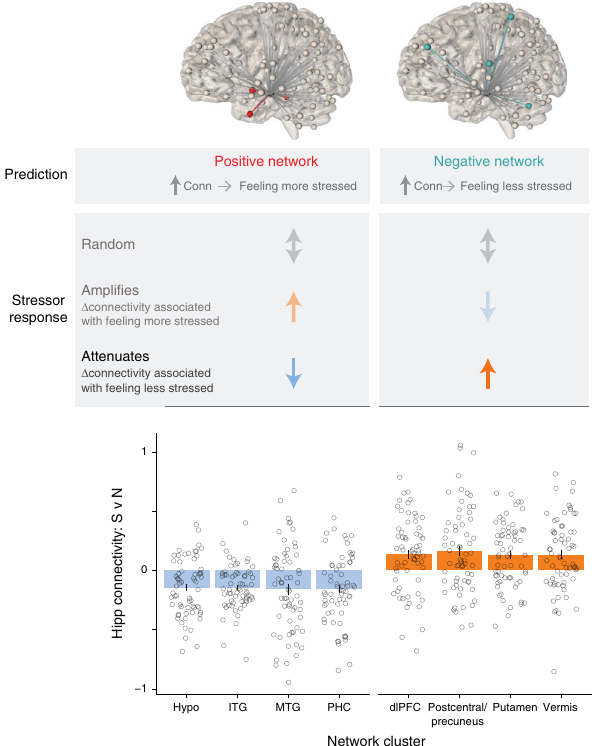
Fig. 3 Hippocampal networks that predict feelings of stress adaptively respond during stressor exposure. Predictive hippocampal networks (de fi ned based on ability to predict feelings of stress) could show several distinct response patterns during stressor exposure. These changes could be random, associated with amplifying feelings of stress, or associated with attenuating feelings of stress. Findings showed that, across participants, every network cluster responded consistent with attenuating feelings of stress. Bar graph shows average connectivity for Stressor vs. Neutral, with overlaid dots showing individual participants. Error bars = + 1 SE. N = 60 participants. Source data are provided as a Source Data fi le.